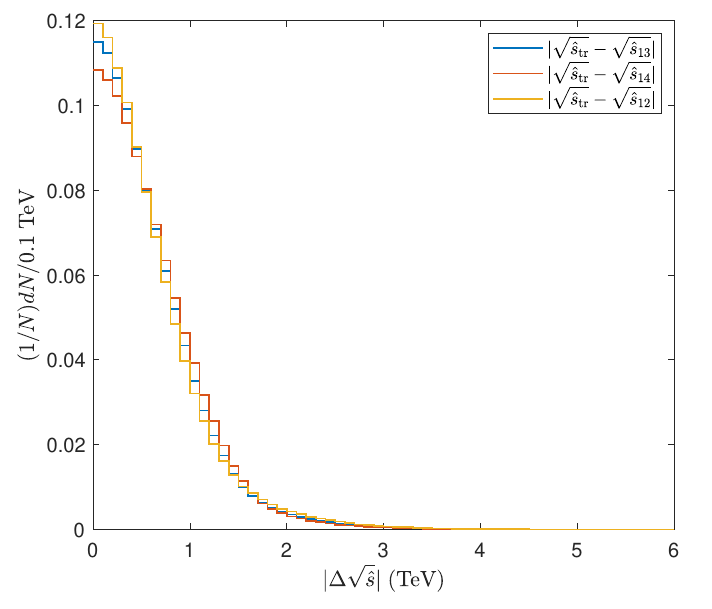
√ ˆ s for ˆ s 12 , 13 , 14 . Note that ˆ s 13 is the ˆ s ann shown in